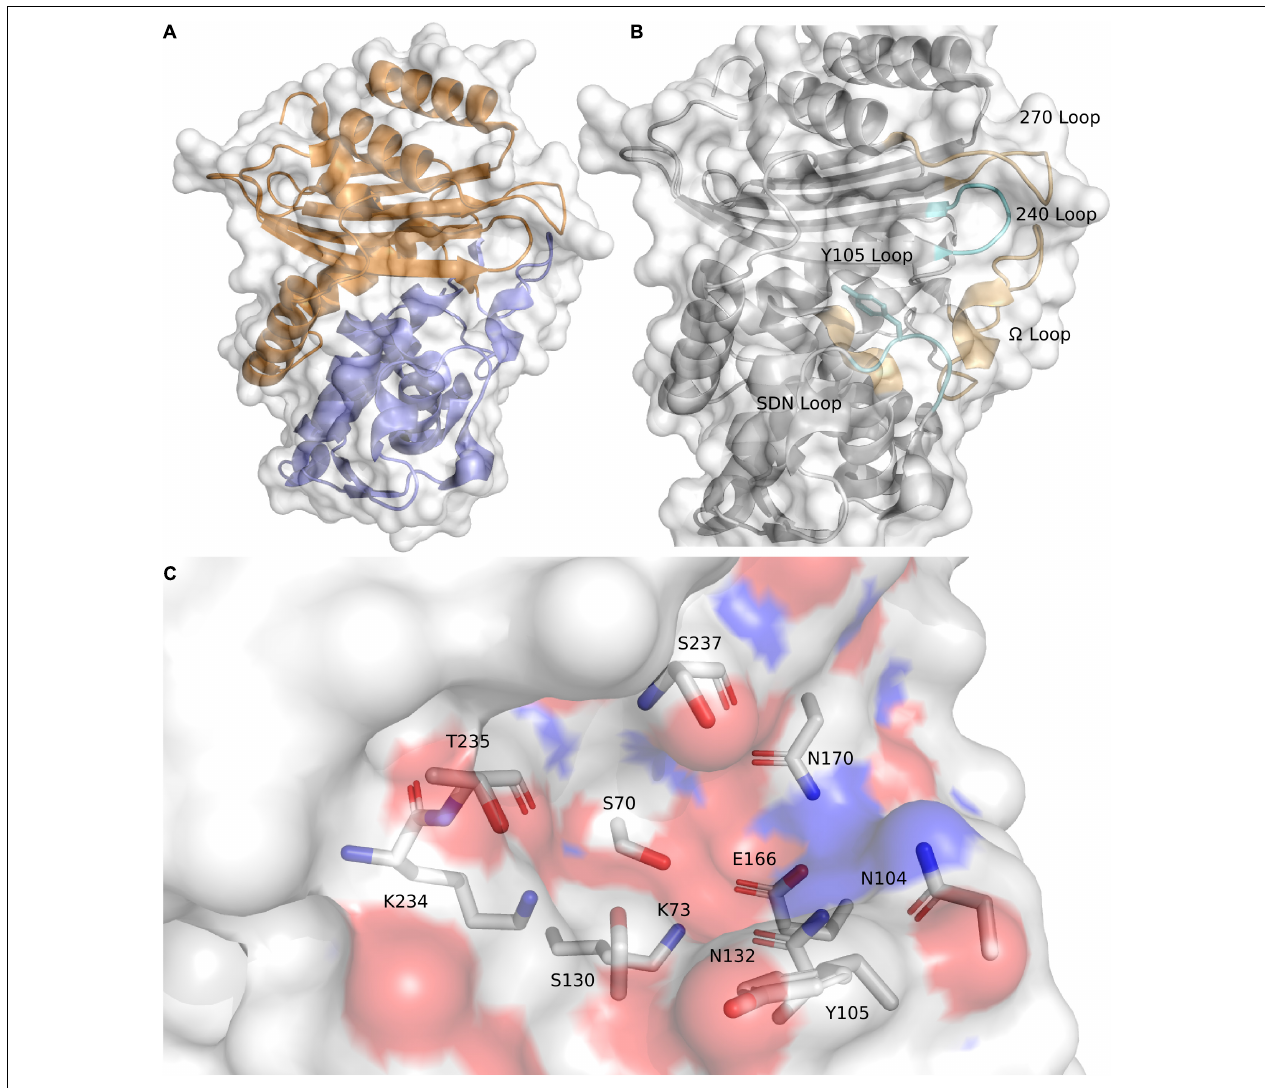
FIGURE 1 | CTX-M-15 architecture. (A) The structure of CTX-M-15 ( white surface ) features two subdomains, an α + β sandwich domain ( orange ) and an α -helical domain ( blue ). (B) Similar to other Class A β -lactamases, CTX-M-15 features the conserved (cid:127) -loop, the 240-loop, the 270-loop, and the SDN-loop. (C) The CTX-M-15 is lined with a set of canonical residues, include the active site serine S70.